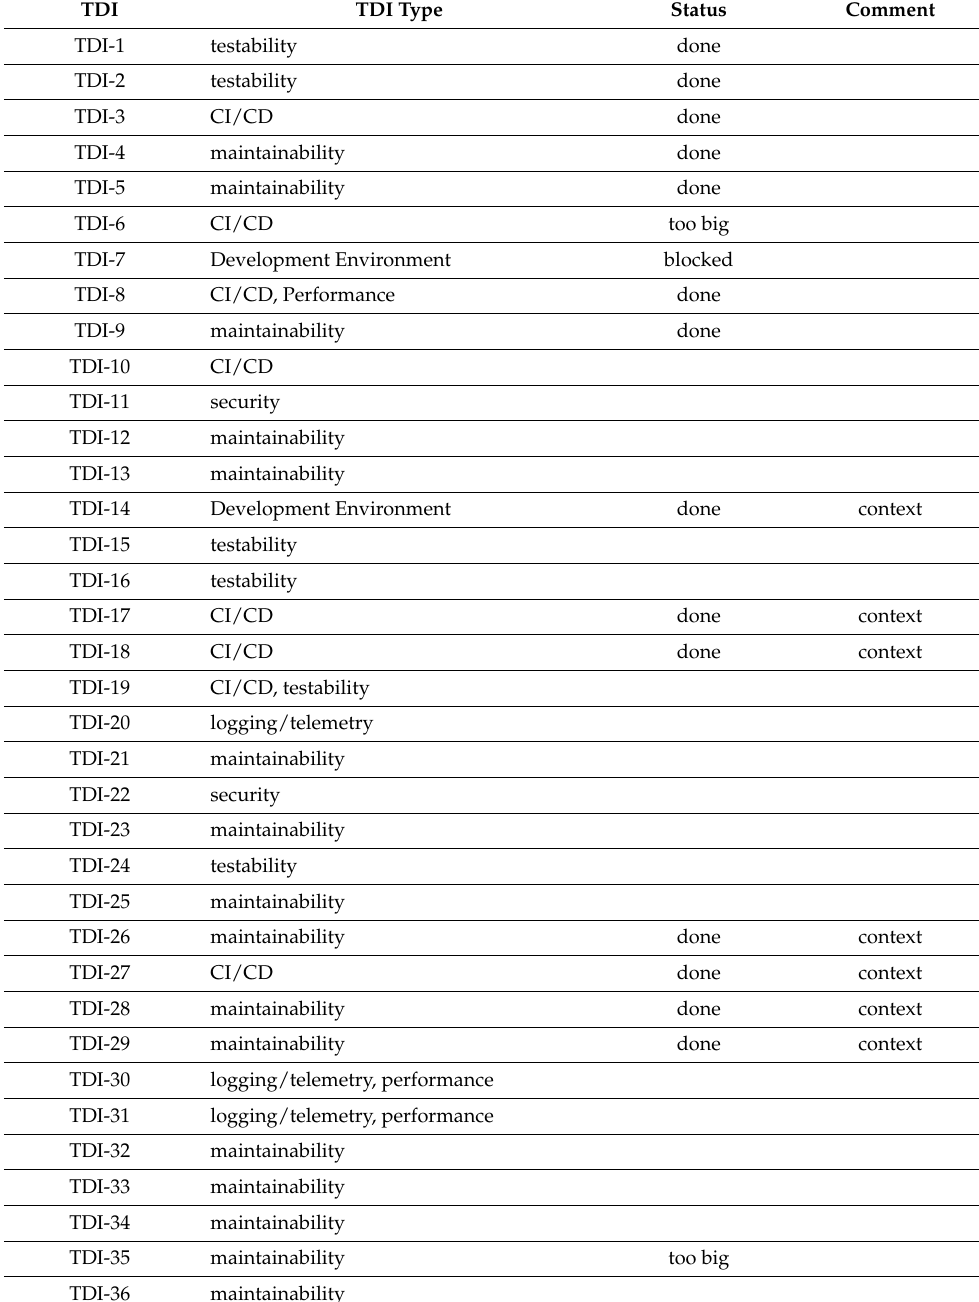
Table 2. Technical Debt Reduction—Prioritized